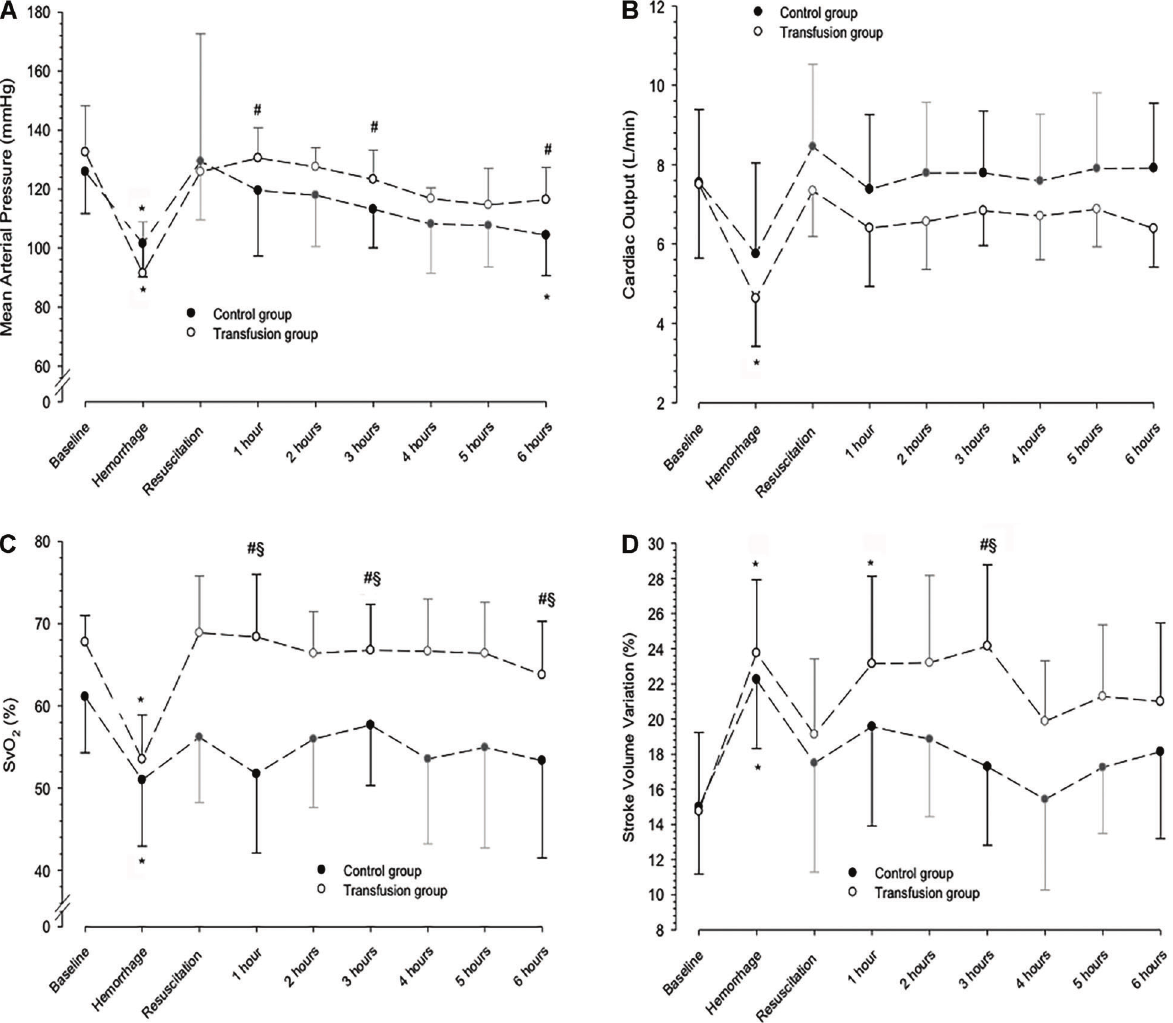
Figure 1. Sequential hemodynamic parameters of the groups during the study. Panel A , Mean systemic arterial blood pressure (ANOVA between factor P=0.156, within factor P o 0.001 and factor-time interaction P=0.054). Panel B , Cardiac output (ANOVA between factor P=0.013, within factor P o 0.001 and factor-time interaction P=0.773). Panel C , Mixed venous oxygen saturation (SvO 2 ) (ANOVA between factor P o 0.001, within factor P o 0.001 and factor-time interaction P=0.019). Panel D , Stroke volume variation (ANOVA between factor P=0.037, within factor P o 0.001 and factor-time interaction P=0.207). Gray lines and markers denote all data recorded for 8 animals per group. Black markers denote the data that were chosen a priori to be analyzed. *P o 0.05 vs baseline, # P o 0.05 vs control group, y P o 0.05 vs hemorrhage ( post-hoc Bonferroni